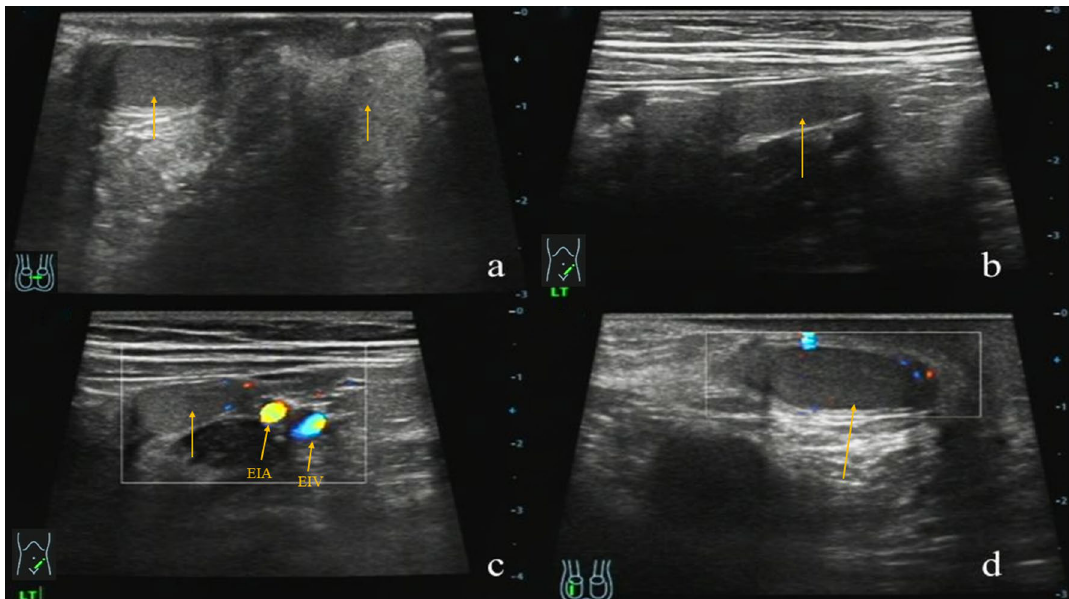
Figure 3. Ultrasound features of IAT on the left side of an 8-months-old boy. (a) The cross section of the scrotum showed that the left testicular was not in the left scrotum, and the right testicular was in the right scrotum (b) and the left testicular was showed next to the left external iliac artery (EIA) in the abdominal cavity (c) the left testis without obvious movement, CDFI showed punctate blood flow signal in the parenchyma (d) and the longitudinal section and the CDFI showed that the right testis was normal